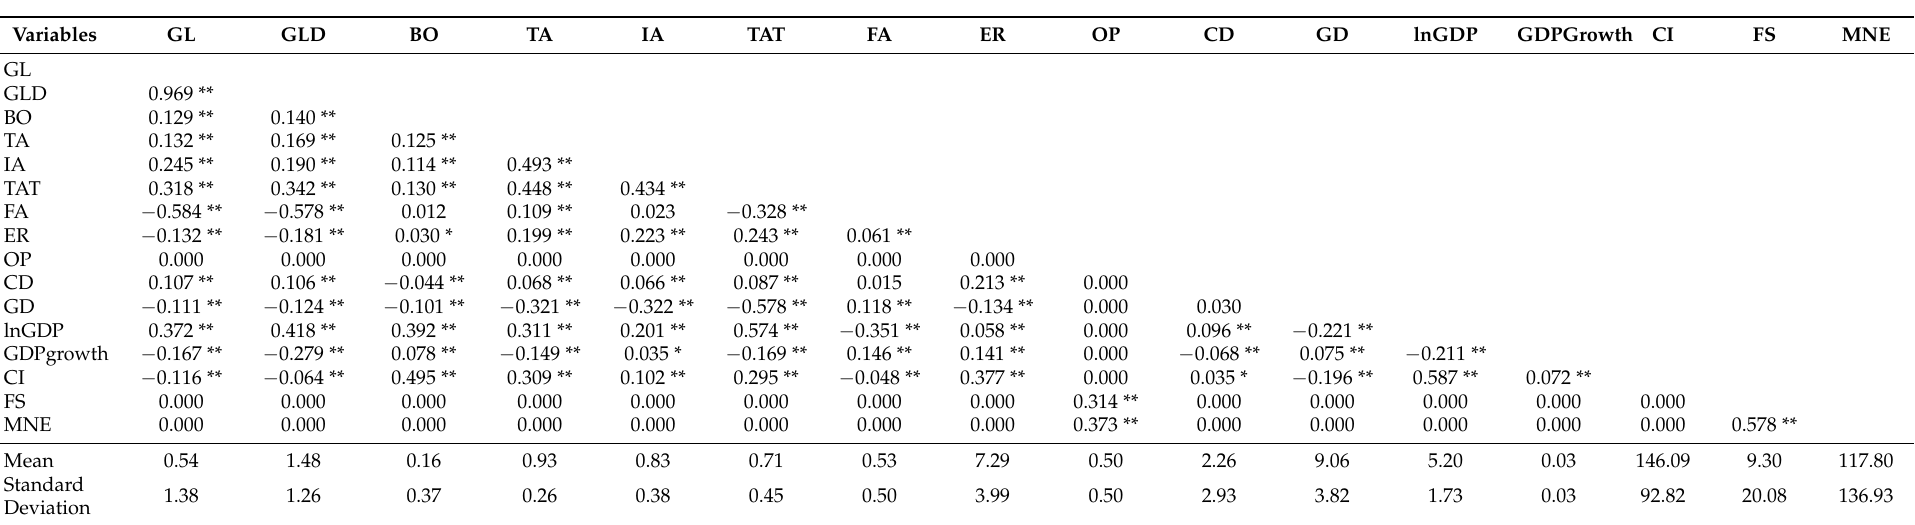
Table 3. Correlation matrix and description statistics.